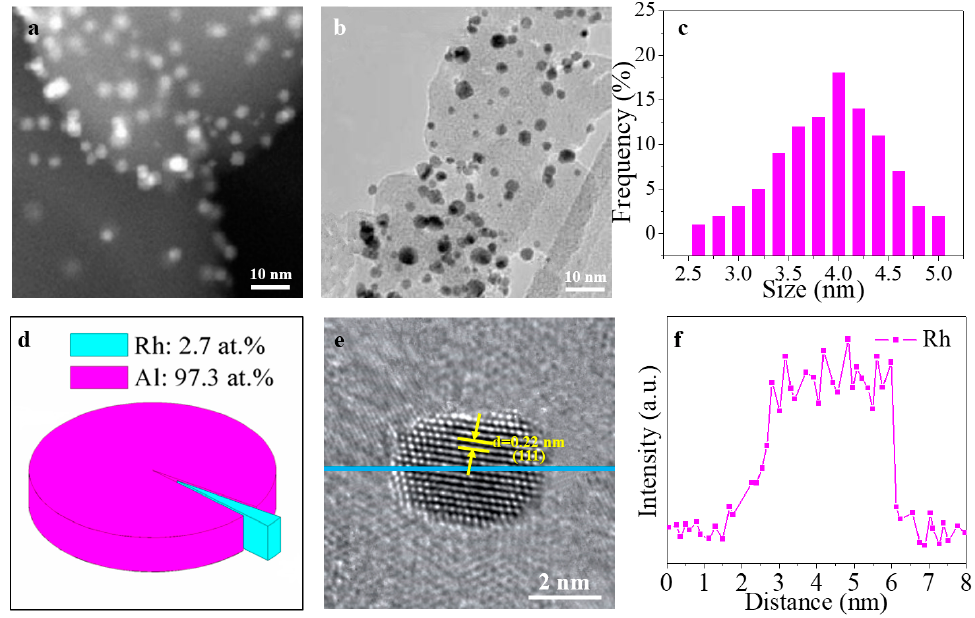
Figure 3. TEM characterization of Rh/ γ -Al 2 O 3 catalysts synthesized by IWI: ( a ) STEM image; ( b ) TEM image; ( c ) Rh size distribution; ( d ) Rh/Al atomic ratio based on the EDX data; ( e ) HRTEM image; ( f ) EDX spectrum.